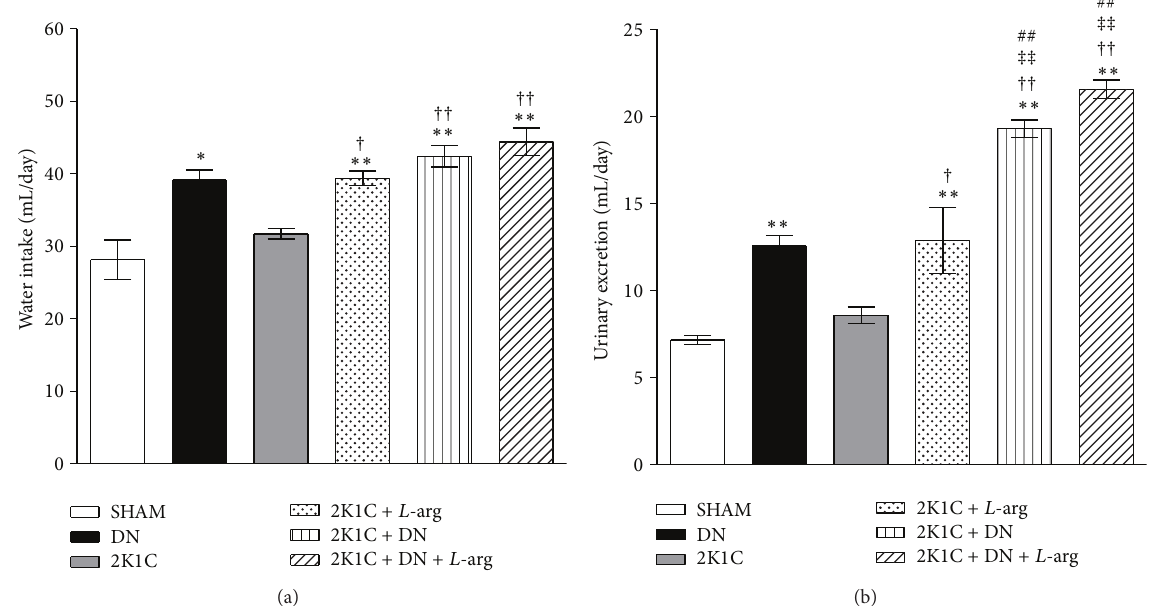
Figure 2: Water intake (a) and urinary excretion (b) after oral L -arginine ( L -arg) administration to the SHAM, two-kidney one-clip, and denervated groups. The groups are as follows: SHAM: normotensive control; 2K1C: two-kidney one-clip; 2K1C+ L -arg: two-kidney one-clip treated with L -arginine; DN: denervated normotensive; 2K1C+DN: denervated two-kidney one-clip; and 2K1C+DN + L -arg: denervated two-kidney one-clip treated with L -arginine. The data are shown for 7 days of L -arg administration. Data are reported as the means ± SEM. ∗ 𝑃 < 0.05 and ∗∗ 𝑃 < 0.01 compared with SHAM; † 𝑃 < 0.05 and †† 𝑃 < 0.01 compared with 2K1C; ‡‡ 𝑃 < 0.01 compared with DN; ## 𝑃 < 0.01 compared with 2K1C+ L -arg (Tukey